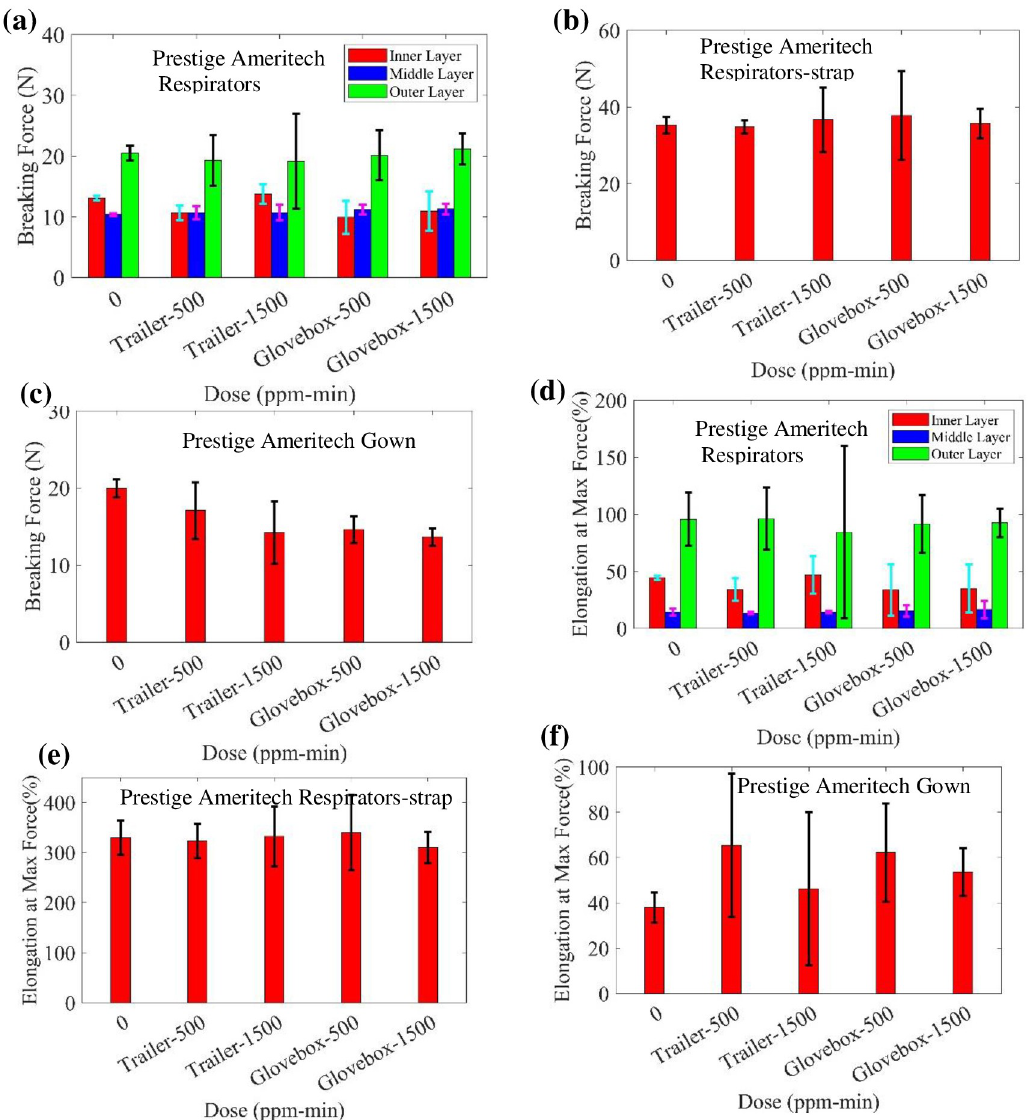
Fig 15. Measured breaking force of treated (a) Prestige Ameritech respirators, (b) straps of respirators, and (c) gowns. Measured elongation at max force of treated (d) Prestige Ameritech respirators, I straps of respirators, and (f)